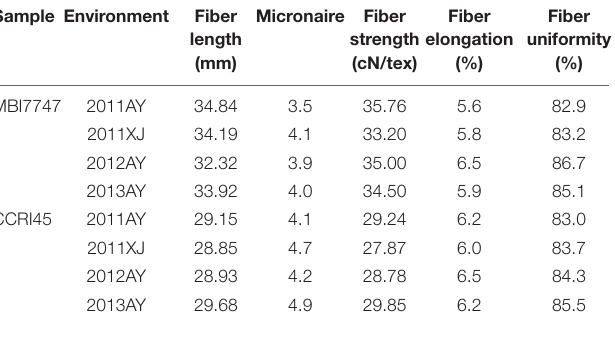
TABLE 1 | Fiber quality traits for the CCRI45 and MBI7747 lines.